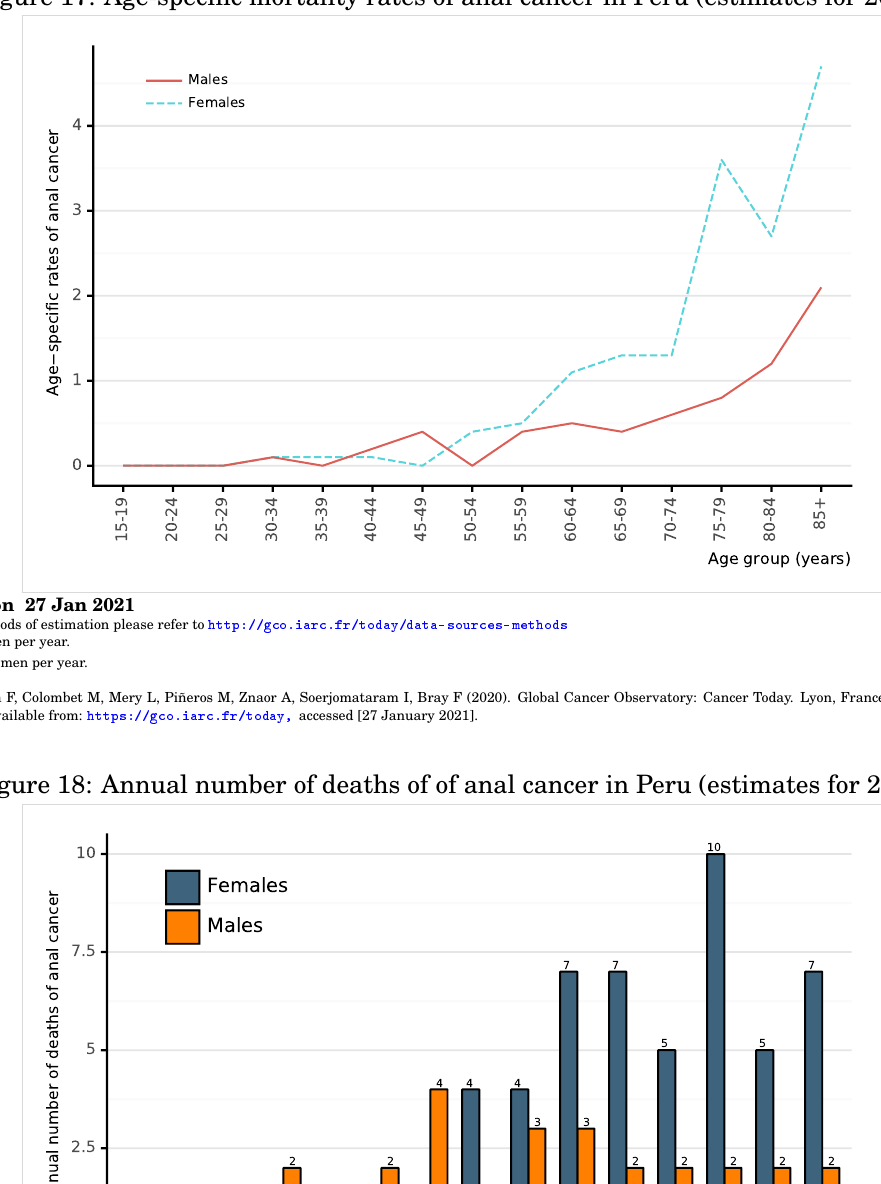
Figure 17: Age-specific mortality rates of anal cancer in Peru (estimates for 2020)